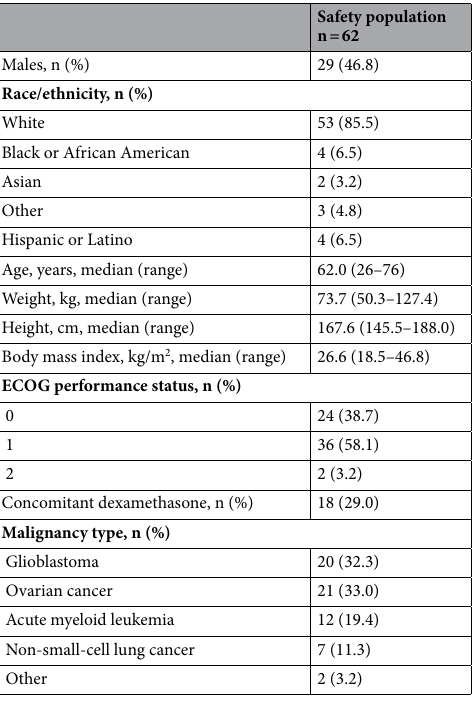
Table 1. Demographics, patient characteristics, and cancer history at baseline. ECOG Eastern Cooperative Oncology